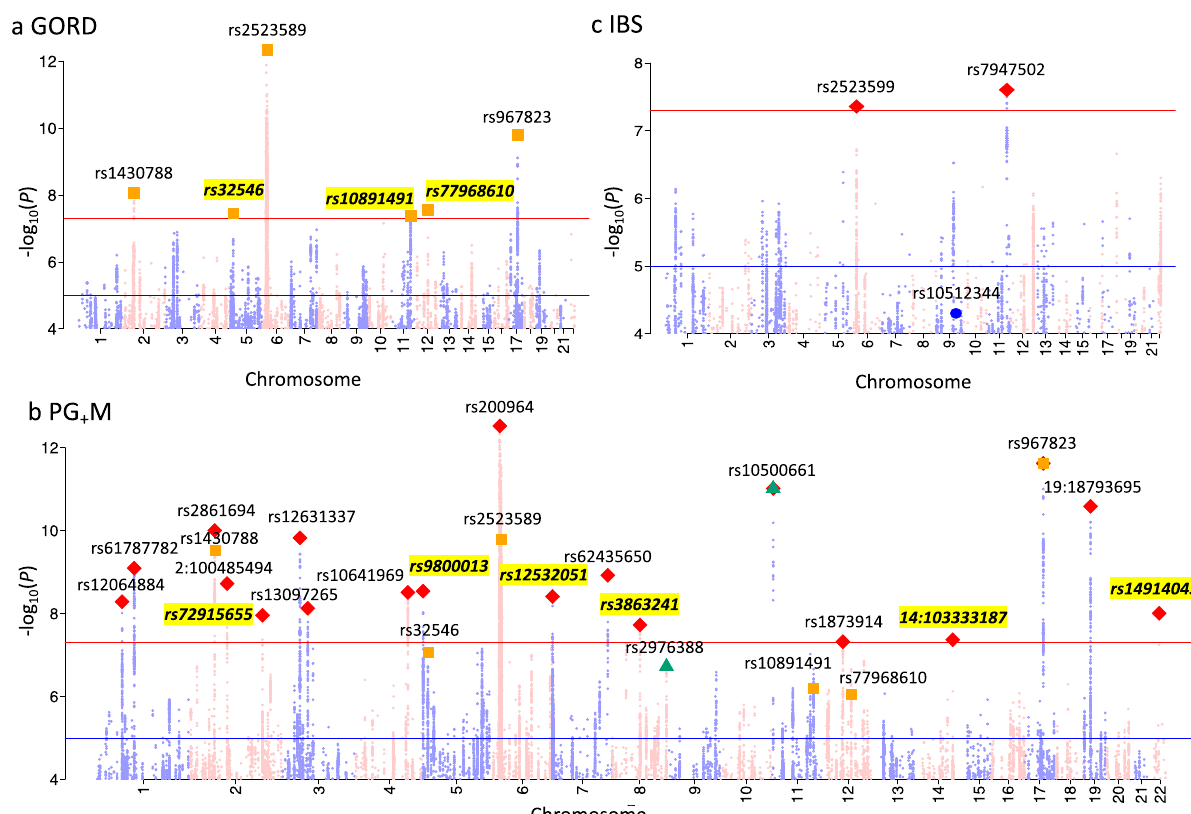
Fig. 3 Manhattan plot of gastroesophageal re fl ux disease (GORD), peptic ulcer disease, GORD and corresponding medications (PG + M) and irritable bowel syndrome (IBS) for SNPs associated P < 1.0E − 4 from BOLT-LMM association test. a GORD: SNPs highlighted with orange squares are genome- wide statistically signi fi cant ( P < 5.0E − 8) independent loci, which correspond to the orange squares in b . SNPs highlighted with yellow represent loci that have not previously been reported to be associated with GORD. b PG + M: SNPs highlighted with red diamond are independent loci with P < 5.0E − 8. Only two of eight SNPs associated with peptic ulcer disease (highlighted with green triangles) are with P < 1.0E − 5 in PG + M and all the SNPs associated with GORD (highlighted with orange squares) have P < 1.0E − 5 in PG + M. SNPs highlighted with yellow represent loci that have not previously been reported to be associated with GORD. c IBS: SNPs highlighted with red diamond are independent loci with P < 5.0E − 8. The blue dot is for rs10512344 that has been reported associated with female IBS in UKB previously released data 23 . The IBD Manhattan plot is found in Supplementary Fig.